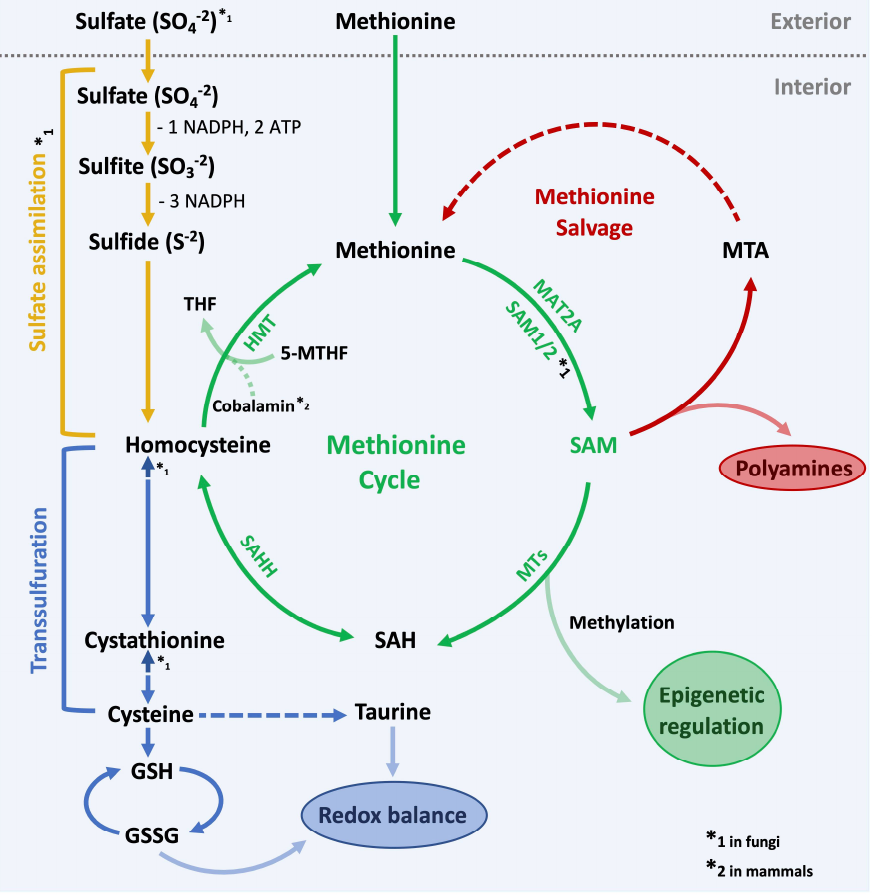
Figure 1. Methionine metabolism. Overview of the methionine cycle and other tightly coupled metabolic pathways. In green the methionine cycle, which quickly converts methionine to S-Adenosylmethionine (SAM) to generate methylation potential for the cell. Enzymes in the methionine cycle: MAT2A (methionine adenosyl transferase), SAM1/2 (SAM synthetase), Methyltransferases (MTs), SAHH (SAH hydrolase), HMT (Homocysteine methyltransferase). SAM is the primary methyl- group donor and is required for epigenetic regulation and other methylation-controlled processes. In red the methionine salvage pathway: SAM is also required for the synthesis of polyamines. Byprod- ucts of this pathway are recycled to regenerate methionine. In blue the transsulfuration pathway: Homocysteine is converted to cysteine, which feeds into the generation of glutathione (GSH) and taurine to maintain the redox balance in the cell. In yellow the sulfate assimilation pathway: Most fungi are able to generate methionine from absorbed sulfate. This process is energy demanding and consumes 2 ATP and 4 NADPH molecules per one molecule of